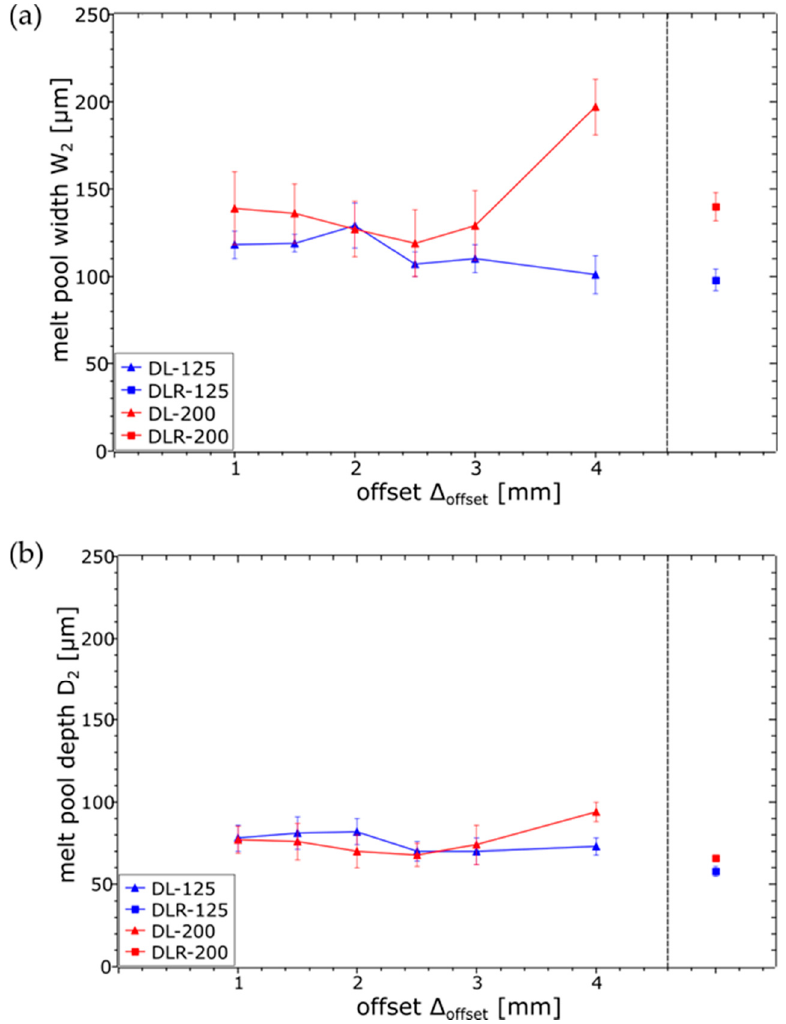
Figure 11. Measured melt pool dimensions (( a ) width W 2 and ( b ) depth D 2 ) in top layer resulting from laser 2 for the examined process parameter sets.